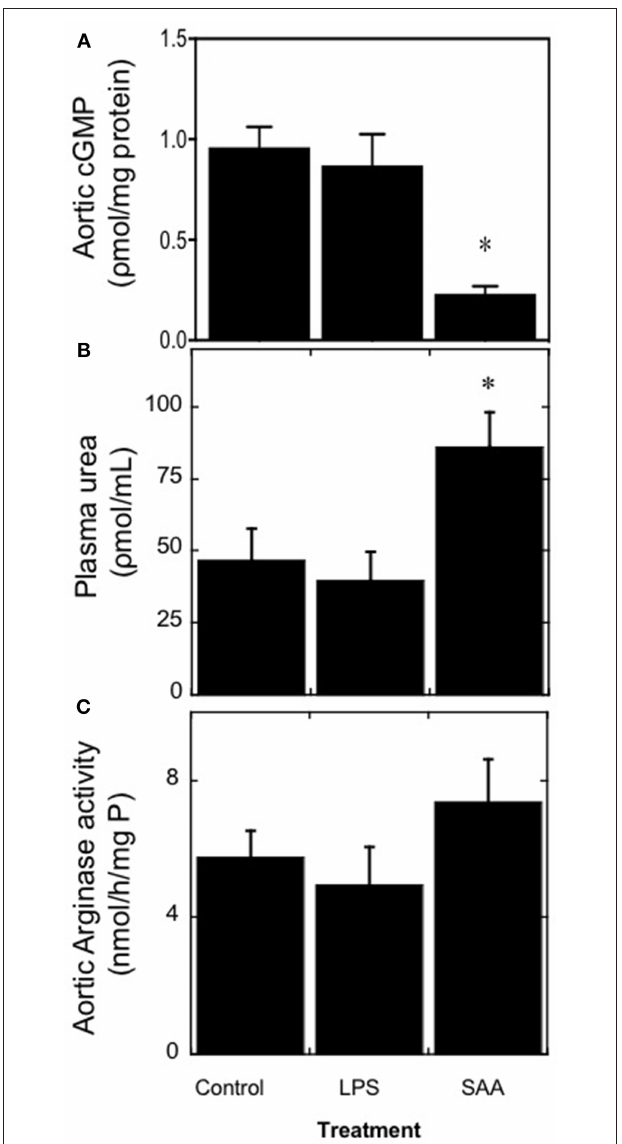
FIGURE 3 | SAA increases circulating urea levels in ApoE − / − mice. Male ApoE − / − mice were administered SAA, LPS or sterile PBS (vehicle control) by i.p. injection over 2 weeks and sacrificed a further 2 weeks after cessation of treatment (as described in Study 1). Aortae were excised and homogenized and then the homogenate samples tested for the levels of (A) cGMP as a surrogate marker for vaso-dilating NO. Plasma levels of (B) urea were quantified and their corresponding isolated aortae (C) assessed for total arginase activity as described in Methods. Data represent mean ± SD , n =